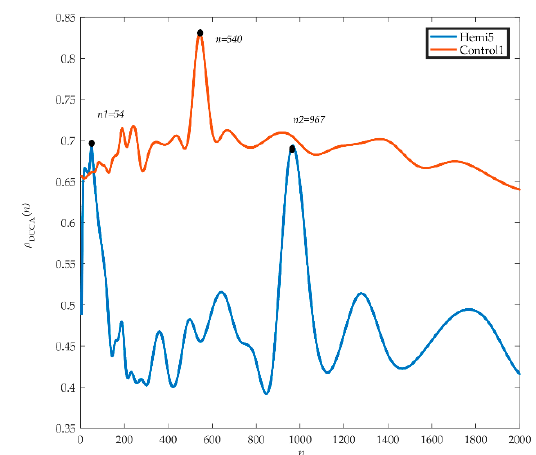
Figure 5. Spectrum of ρ DCCA in healthy control 1 and hemiplegic patient 5.